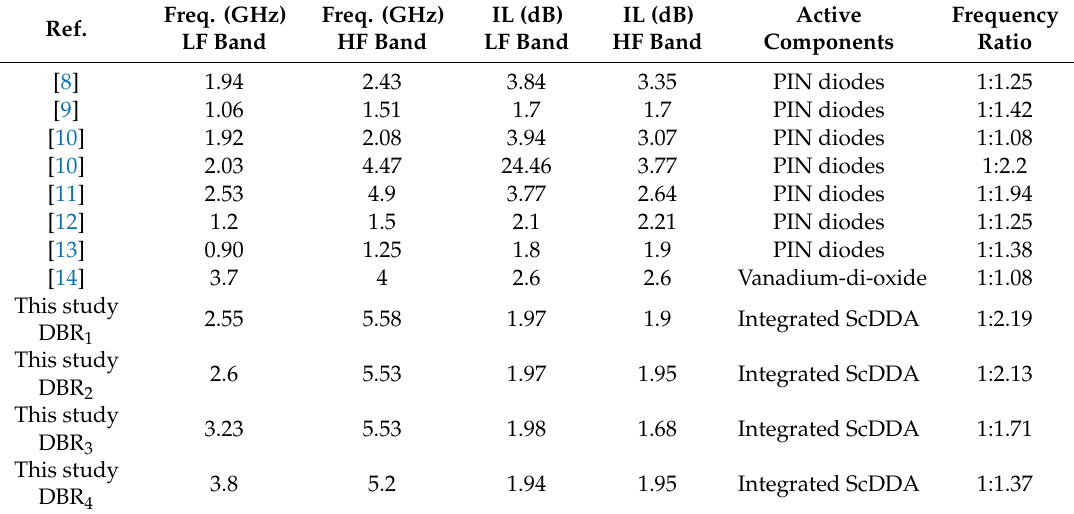
Table 3. Comparison between previous two-state switchable filters and this work.